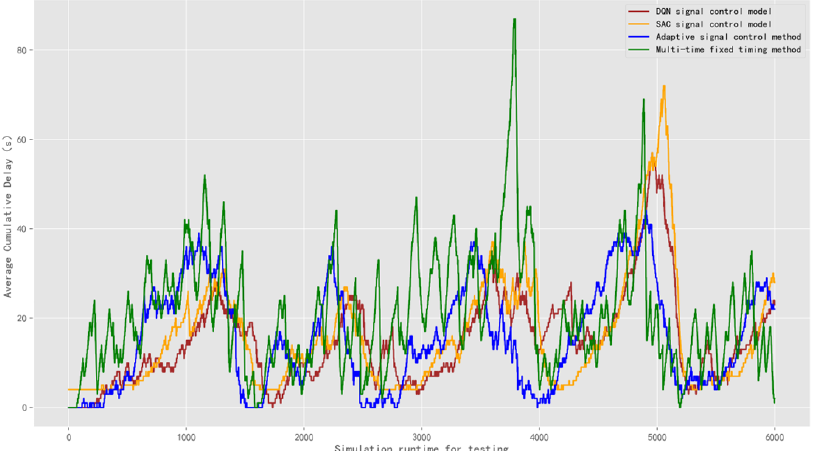
Figure 15. Comparison of the average cumulative delay of signal control methods under test traffic scenario 2.